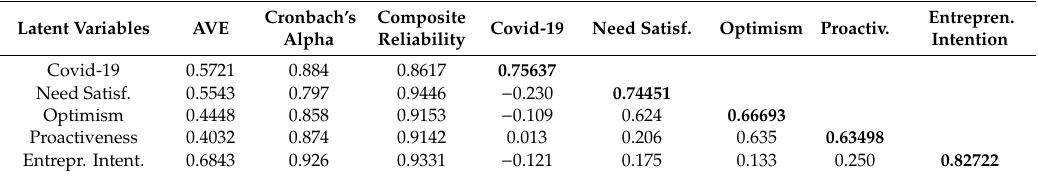
Table A2. Discriminant validity among latent